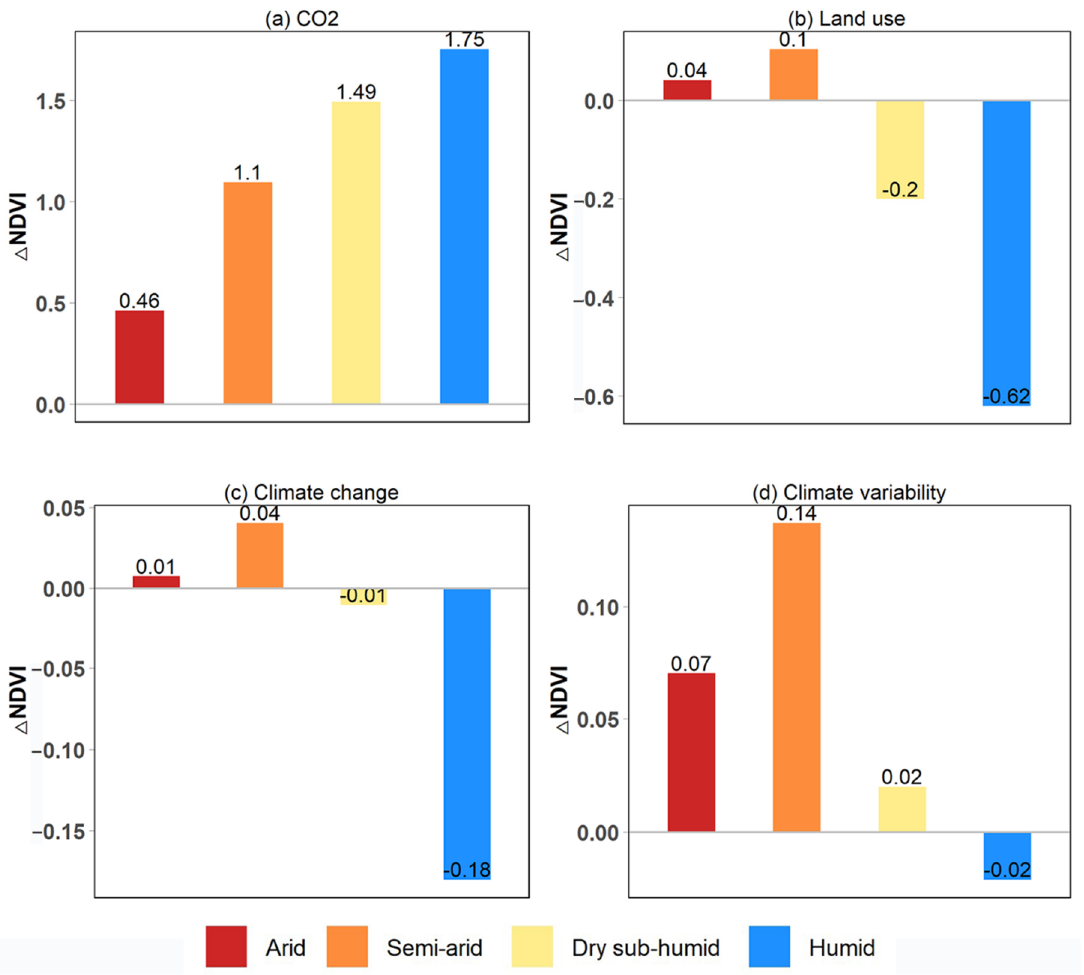
Figure 7. The impacts of ( a ) CO 2 fertilization (CO 2 ), ( b ) land use (LU), ( c ) climate change (CC), and ( d ) climate variability (CV) on observed NDVI changes ( Δ NDVI) in different dry and wet regions during 1982–2015.